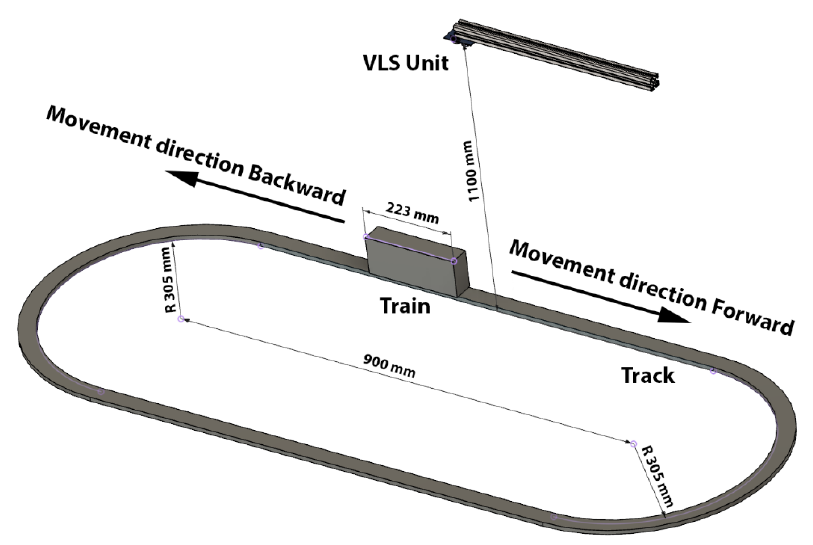
Figure 1. Sketch of the improved experimental setup.